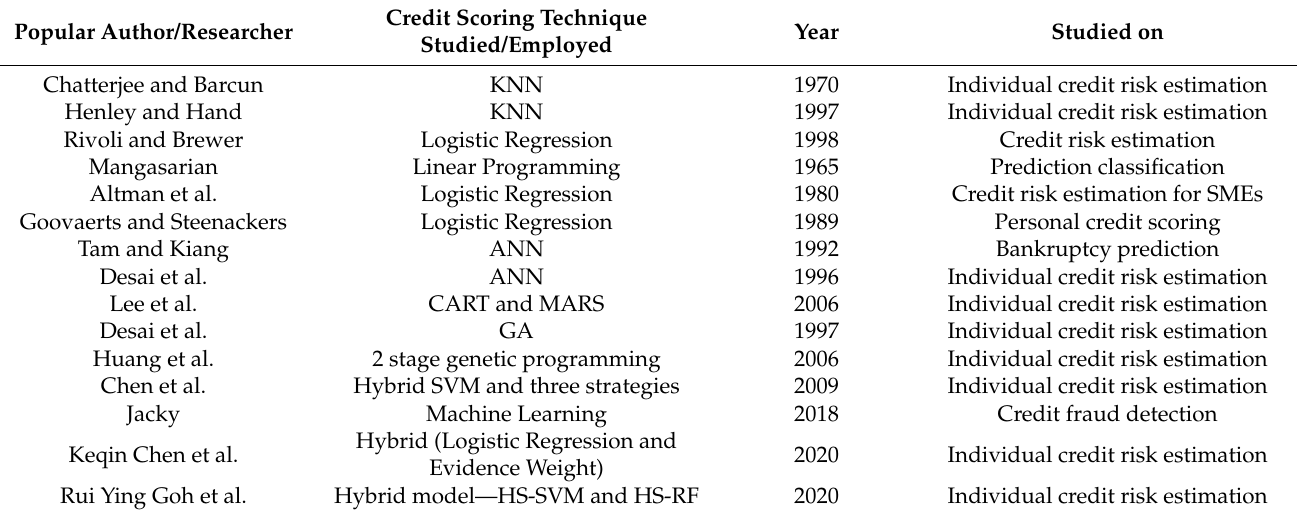
Table 4. Credit scoring techniques introduced or employed by eminent